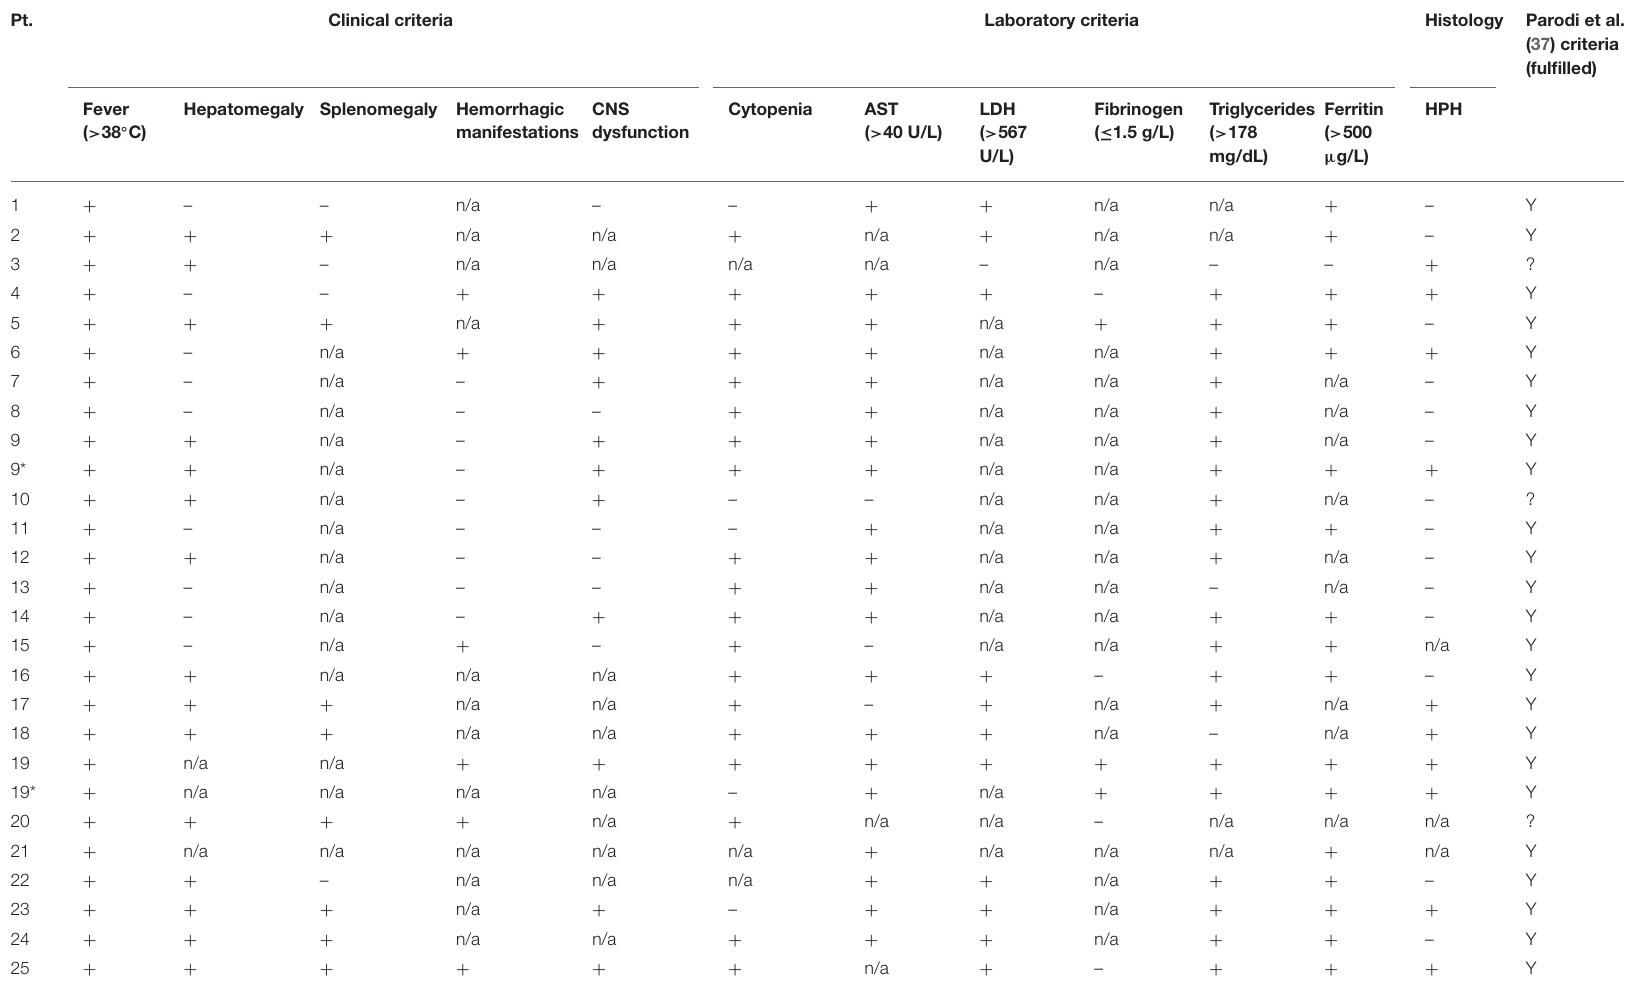
TABLE 5 | Fulfillment of the preliminary criteria by Parodi et al. (37) (for the diagnosis of MAS in pSLE patients) in the reported cases of MAS complicating pSLE.